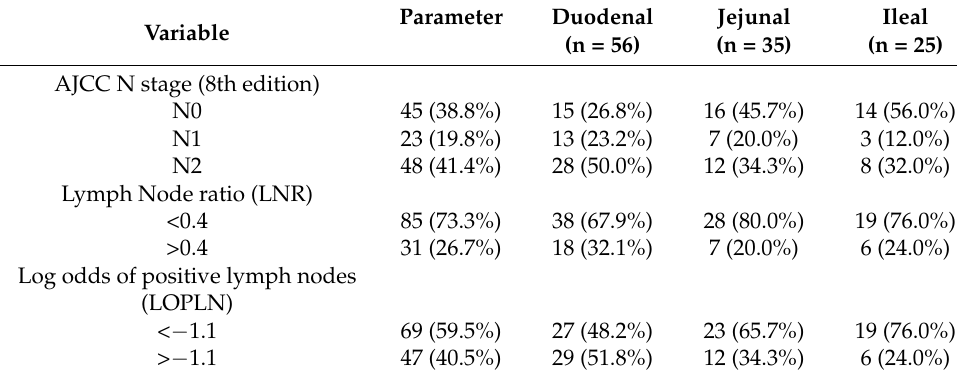
Table 2. Lymph nodes positivity by different methods, n = 116.